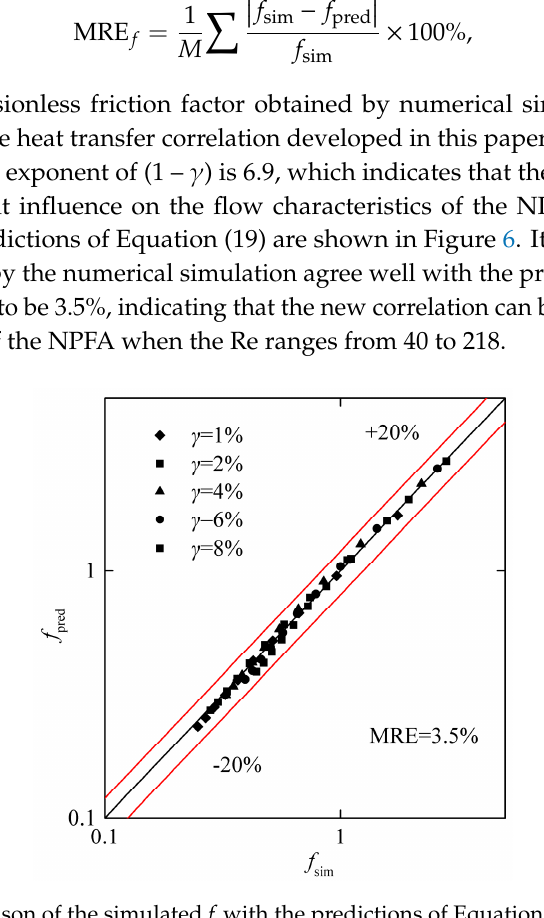
Figure 6. Comparison of the simulated f with the predictions of Equation (19) for the NPFA.